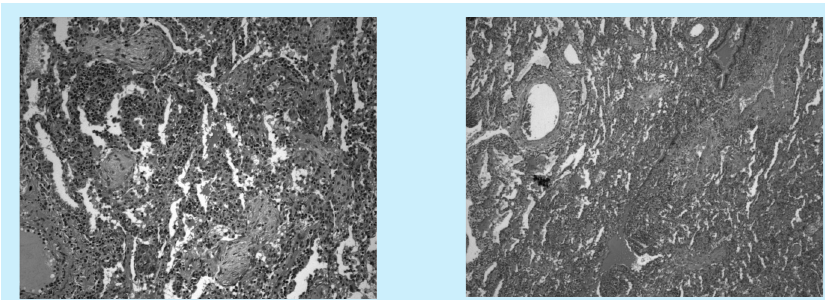
Fig. 3. Interstitial thickening with lymphocytes and plasma cells with granulation tissue type exudates and fibroblast proliferation filling the alveolar spaces.